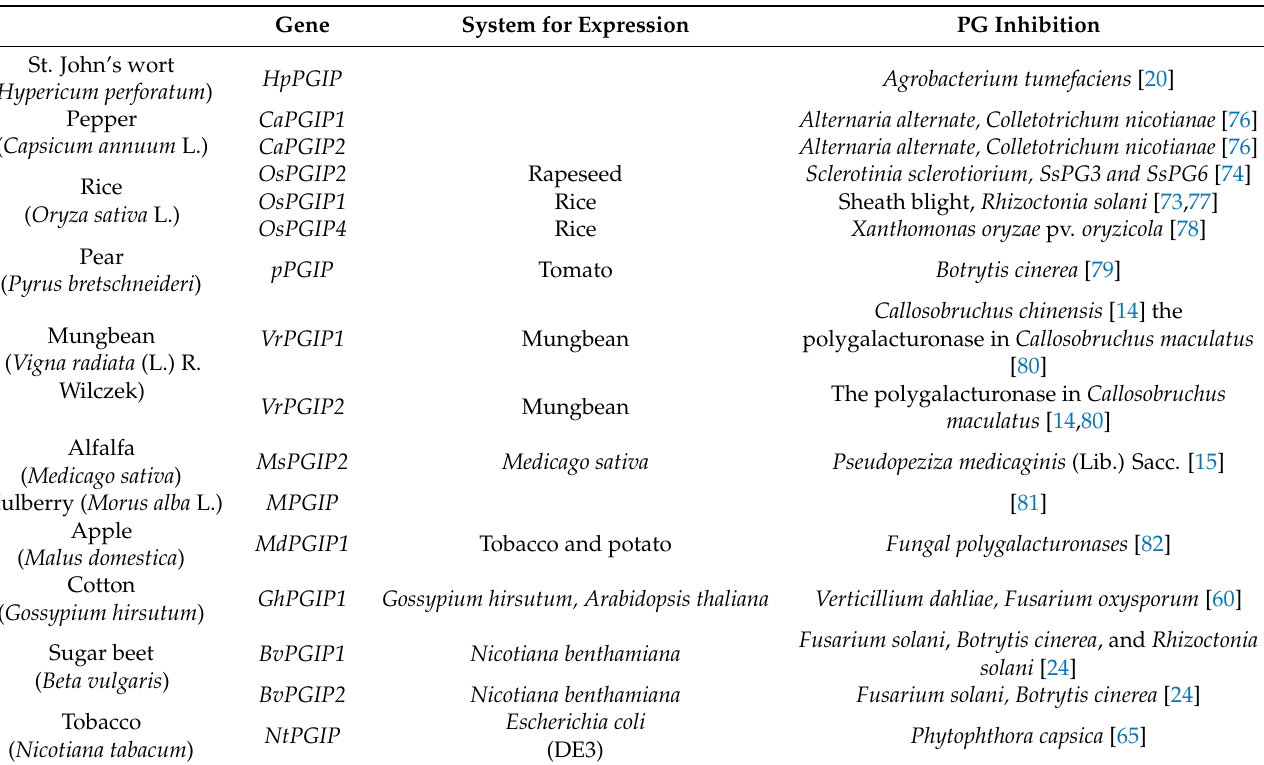
Table 2. PGIP tested in different systems against fungal PGs. Gene System for